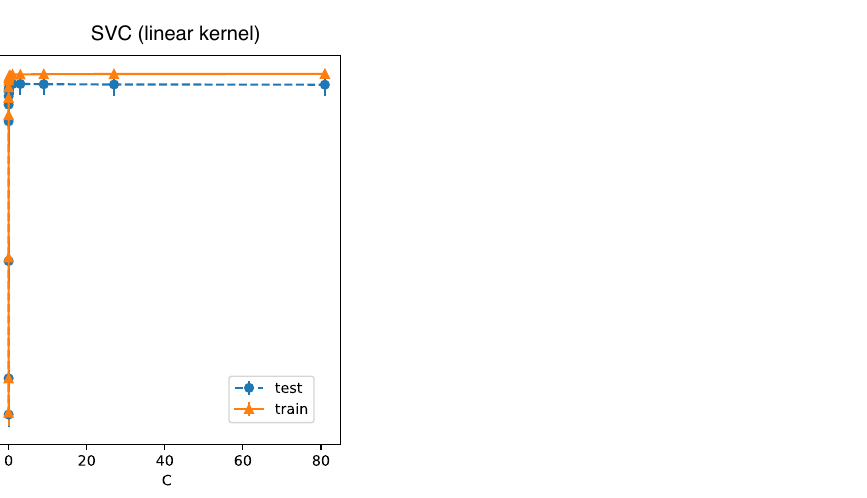
Figure 6. Mean performance of SVC (linear kernel) models for respective evaluated hyperparameters with standard deviation.